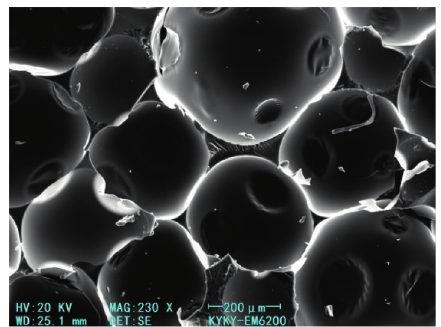
Figure 10: Microscopic characteristics of low density.